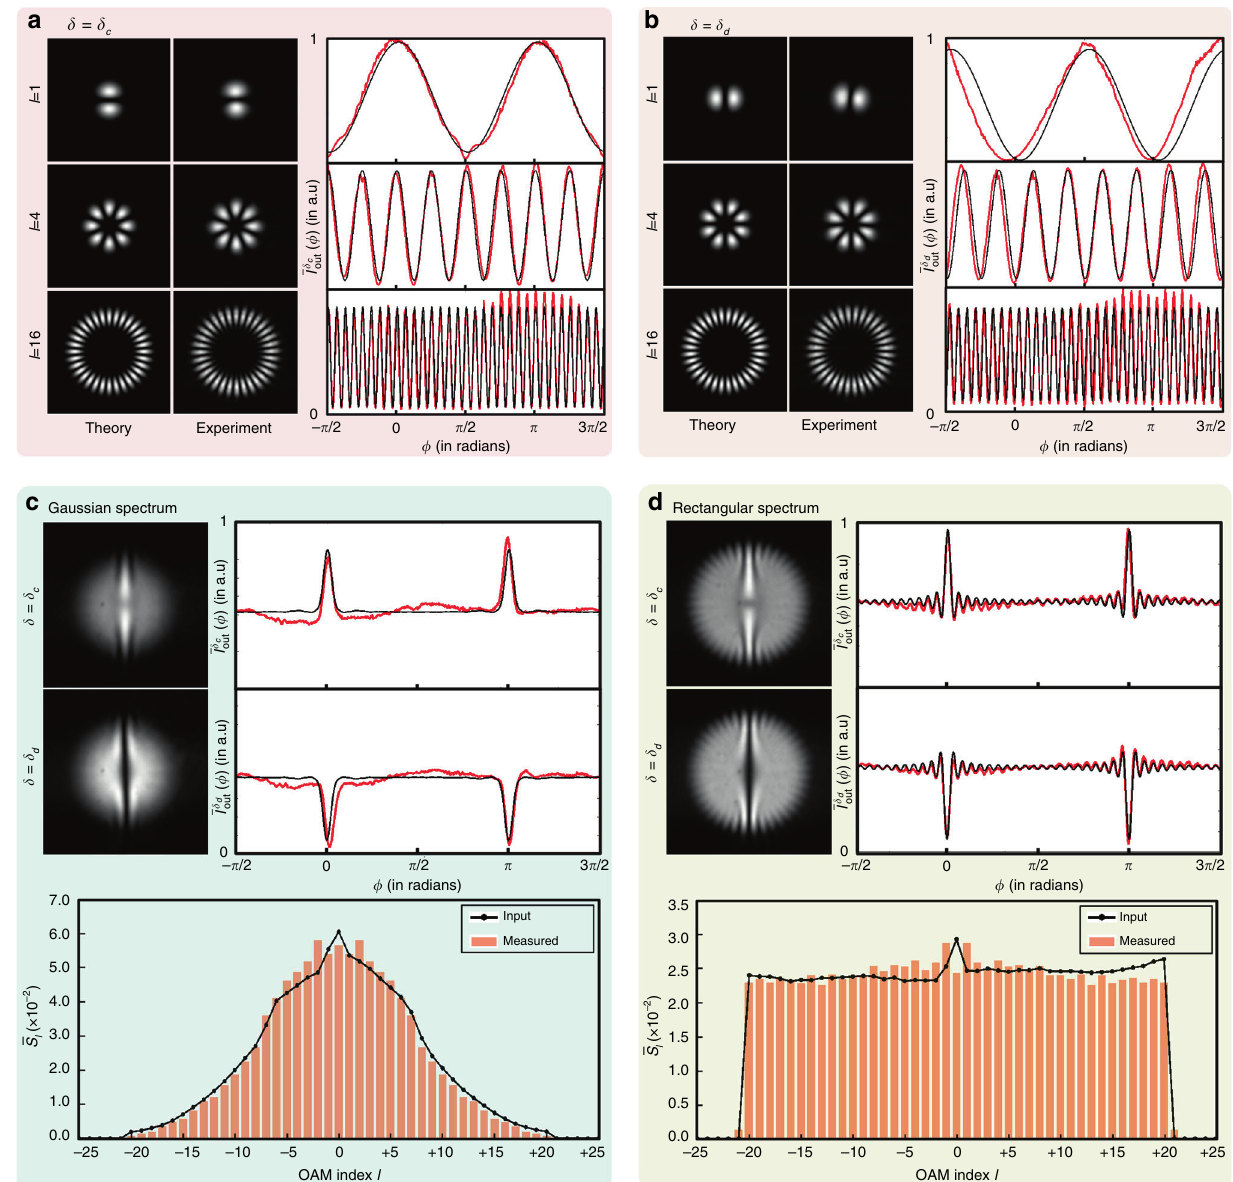
Fig. 2 Experimental results obtained with the lab-synthesized fi elds. a , b Measured output interferograms and the corresponding azimuthal intensities for ρ ; ϕ ð Þ modes with l = 1, 4, and 16 for δ ≈ 2 m π and δ ≈ (2 m + 1) π , respectively, where m is an integer. c Measured output interferograms, the input LG l p ¼ c d 0 azimuthal intensities, and the measured spectrum for the synthesized input fi eld with a Gaussian OAM-spectrum. d Measured output interferograms, the azimuthal intensities, and the measured spectrum for the synthesized input fi eld with a Rectangular OAM-spectrum. In all the above azimuthal intensity plots, the red lines are the experimental plots and the black lines are the theoretical fi